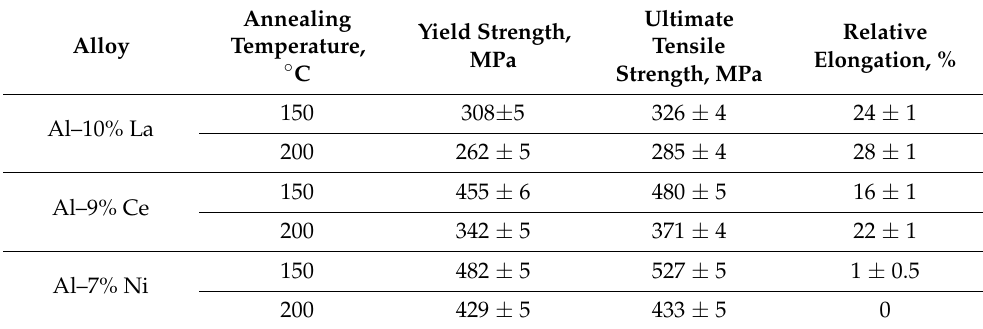
Table 3. Mechanical properties of the HPT-processed eutectic aluminum alloys after subsequent annealing.